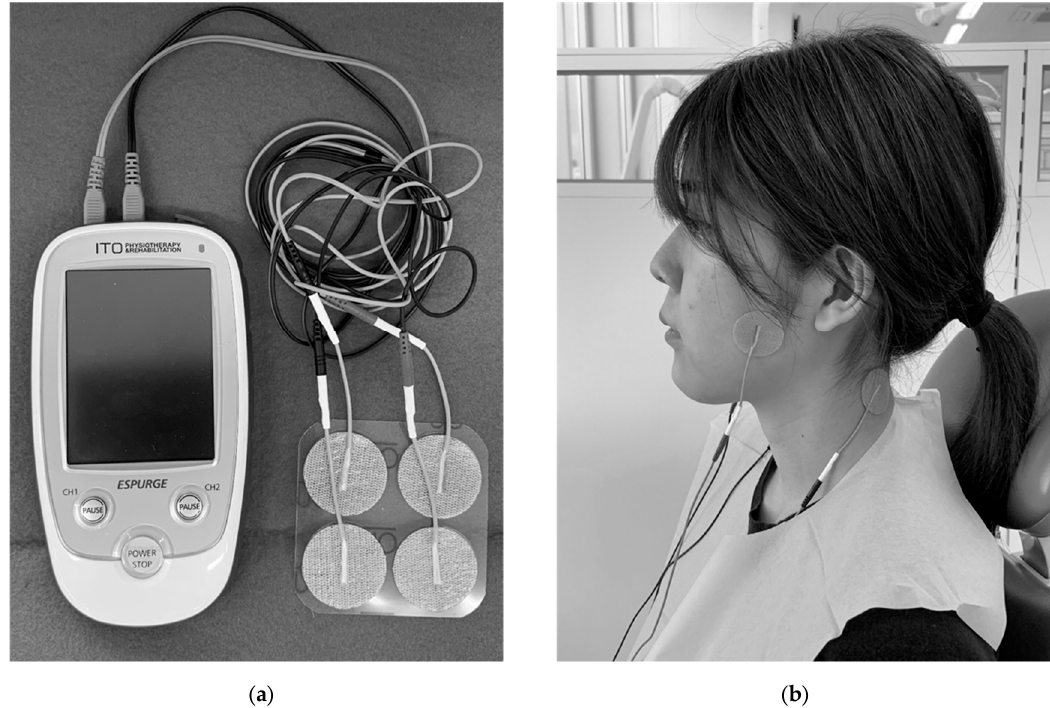
Figure 1. Clinical trial of transcutaneous electrical nerve stimulation (TENS) for pain relief in masticatory muscles. ( a ) The TENS device ESPURGE (ITO CO., LTD, Tokyo, Japan) is used because it is a portable device and easy to use at the chairside. ( b ) Four electrodes are applied to the skin for 20 min at a phase duration of 50 µ s with frequencies of 100–200 Hz (sweep modulation mode).